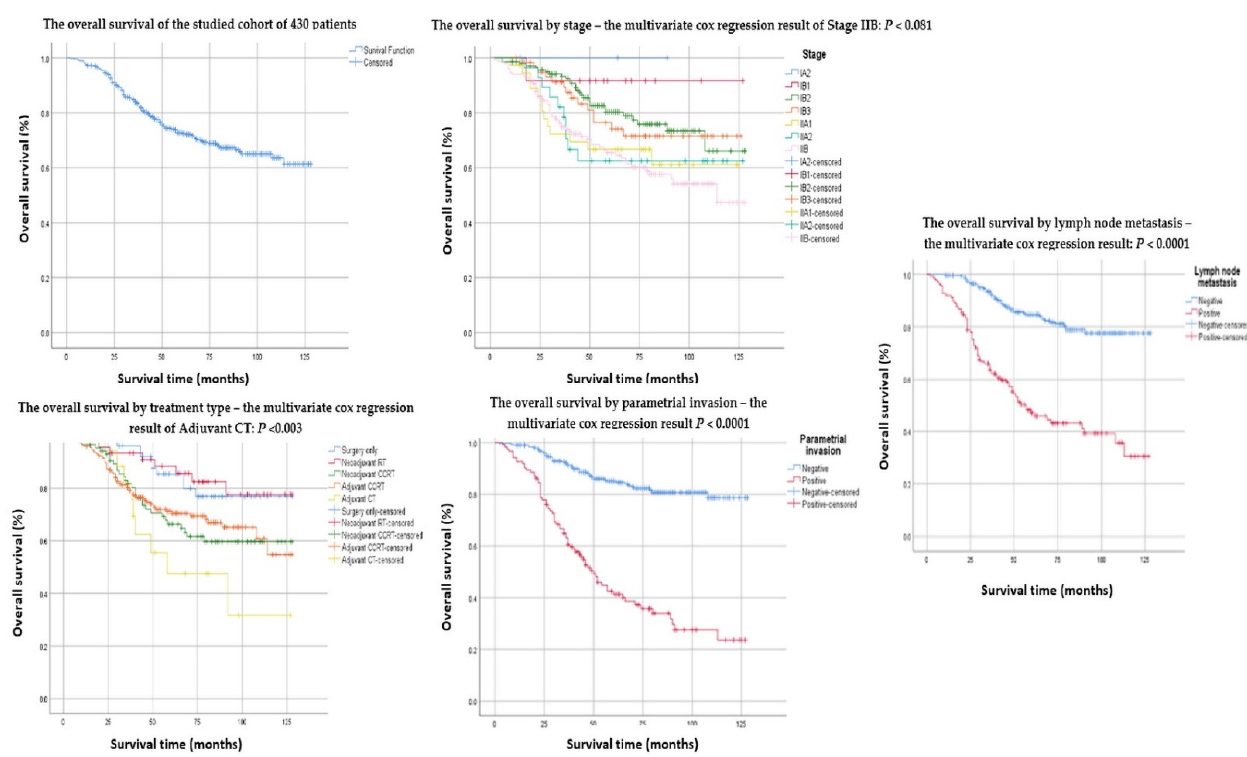
Figure 1. The Kaplan Mayer survival curves.